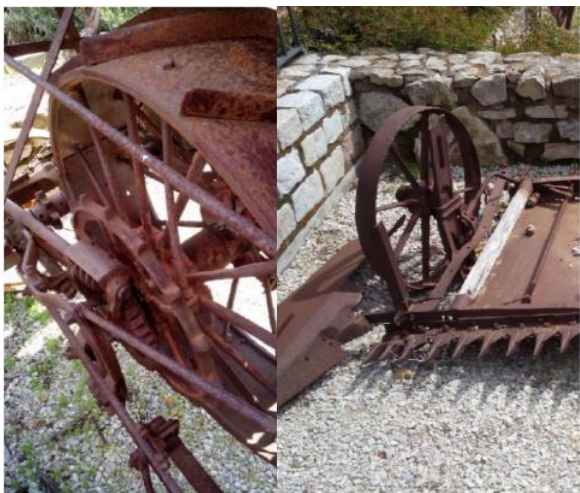
Figure 29. Drive wheel ( left ) and drag wheel ( right ) with adjusting levers.